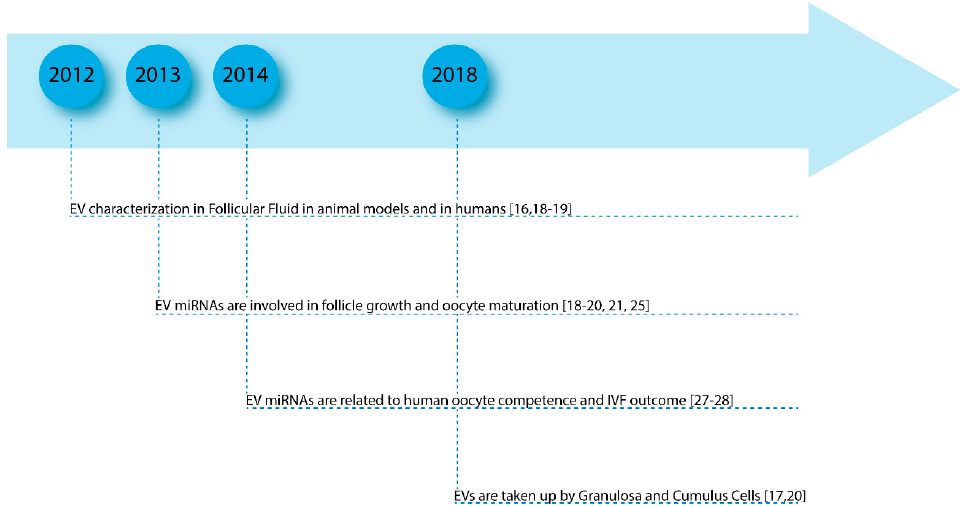
Figure 2. Milestones of the main significant papers about the involvement of EVs in follicle growth and their potential role in fertility disorders.